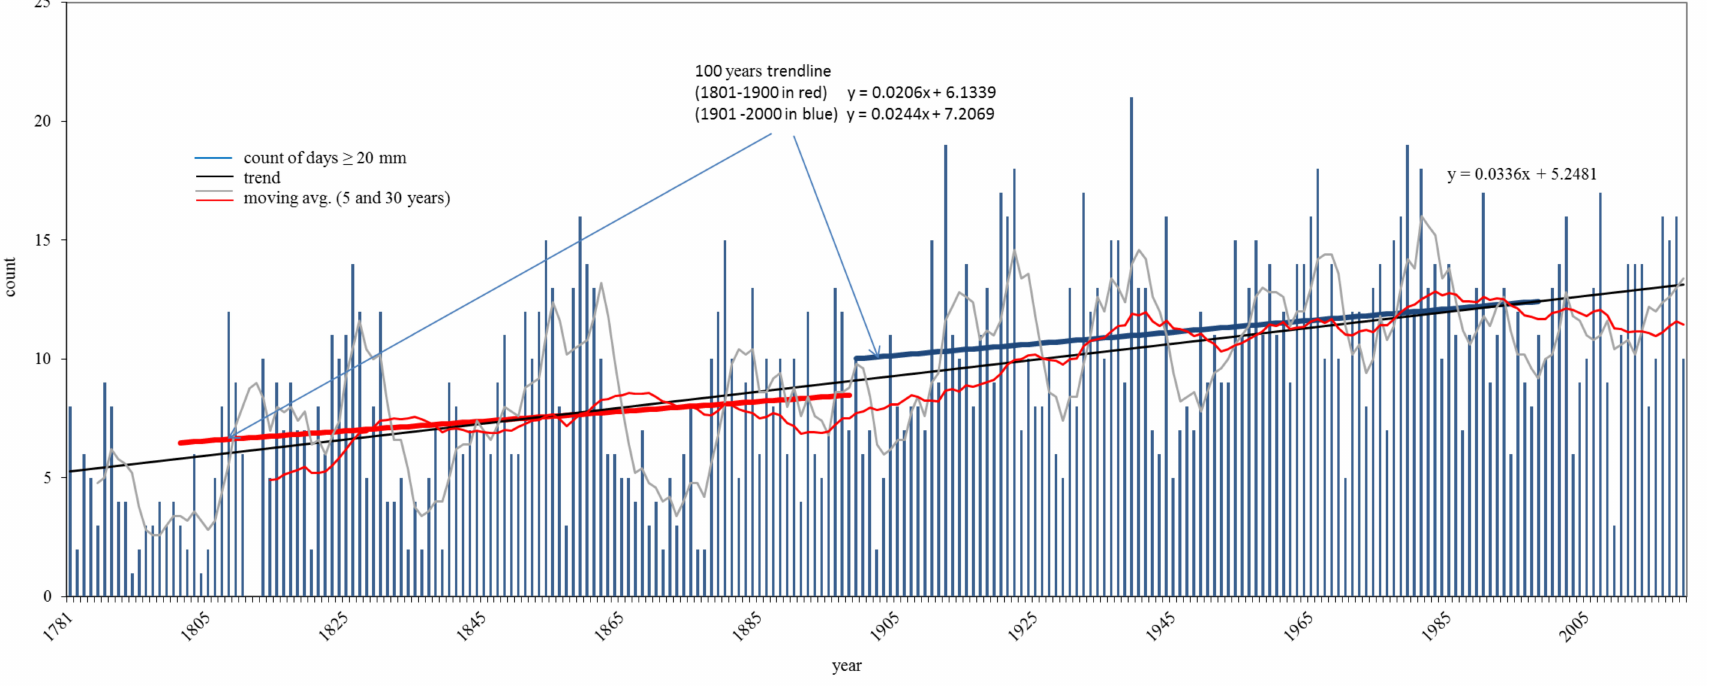
Figure 12. Heavy rainfall days with ≥ 20 mm and trends at Hohenpeißenberg, Alpine foothills, location changes in 1940 and